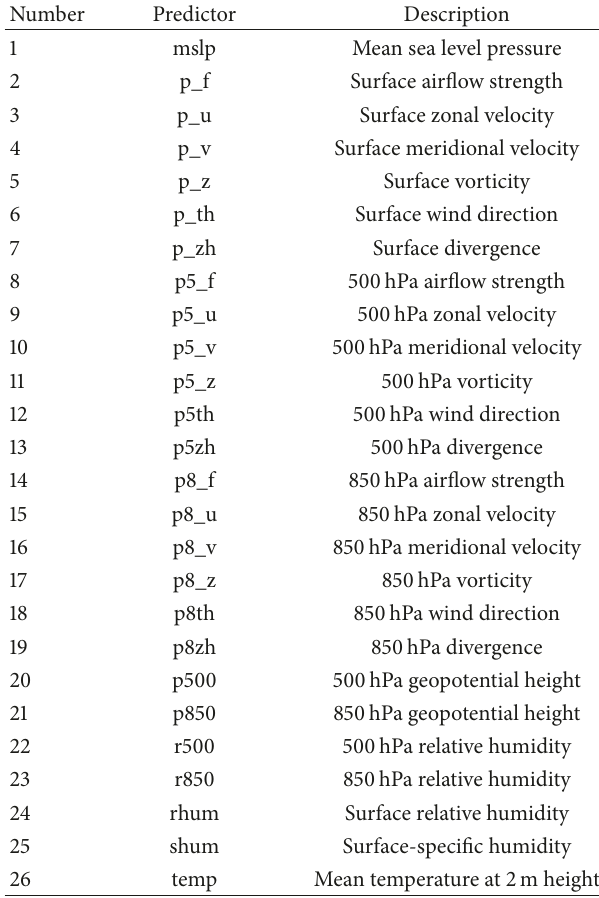
Table 1: NCEP reanalysis